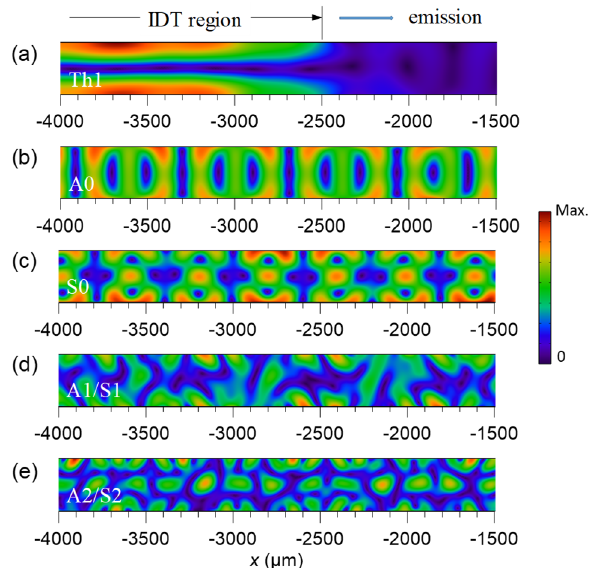
Figure 5. Simulated displacement profiles excited by a single IDT at the corresponding frequencies of ( a ) the thickness-resonance mode, ( b ) propagating A0 mode, ( c ) propagating S0 mode, ( d ) A1/S1 mixed modes, and ( e ) A2/S2 mixed modes.